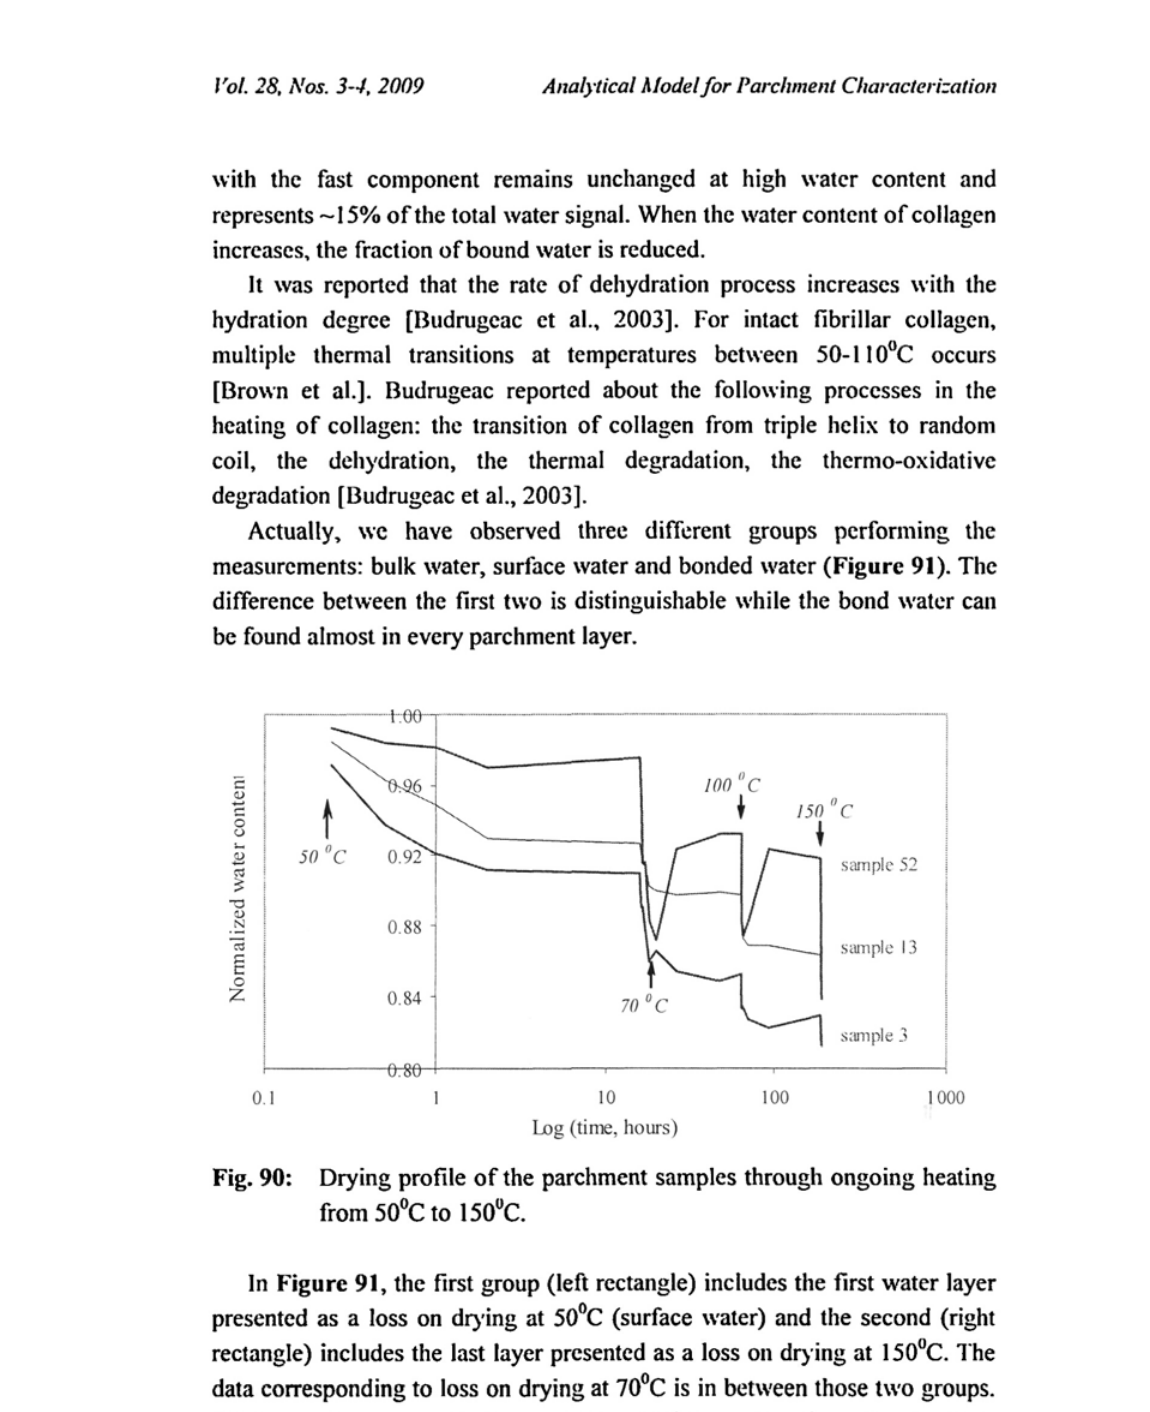
Fig. 90: Drying profile of the parchment samples through ongoing heating